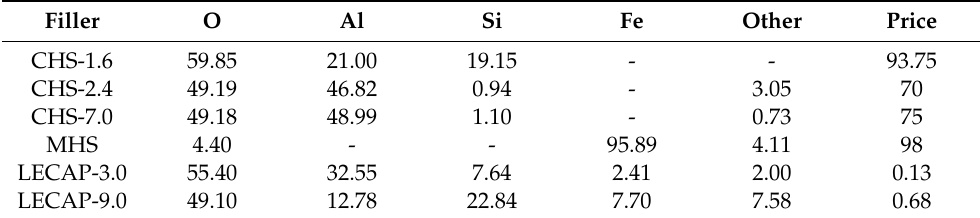
Table 1. Chemical composition (in wt.%) and price (in EUR dm − 3 ) of the filler